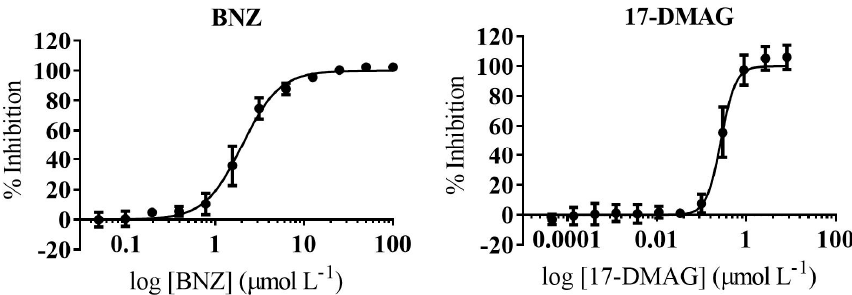
Figure 4. Amastigote-Specific Activity Curves of BNZ and 17-DMAG. Graphs represent mean results and SD of at least three biological replicas.